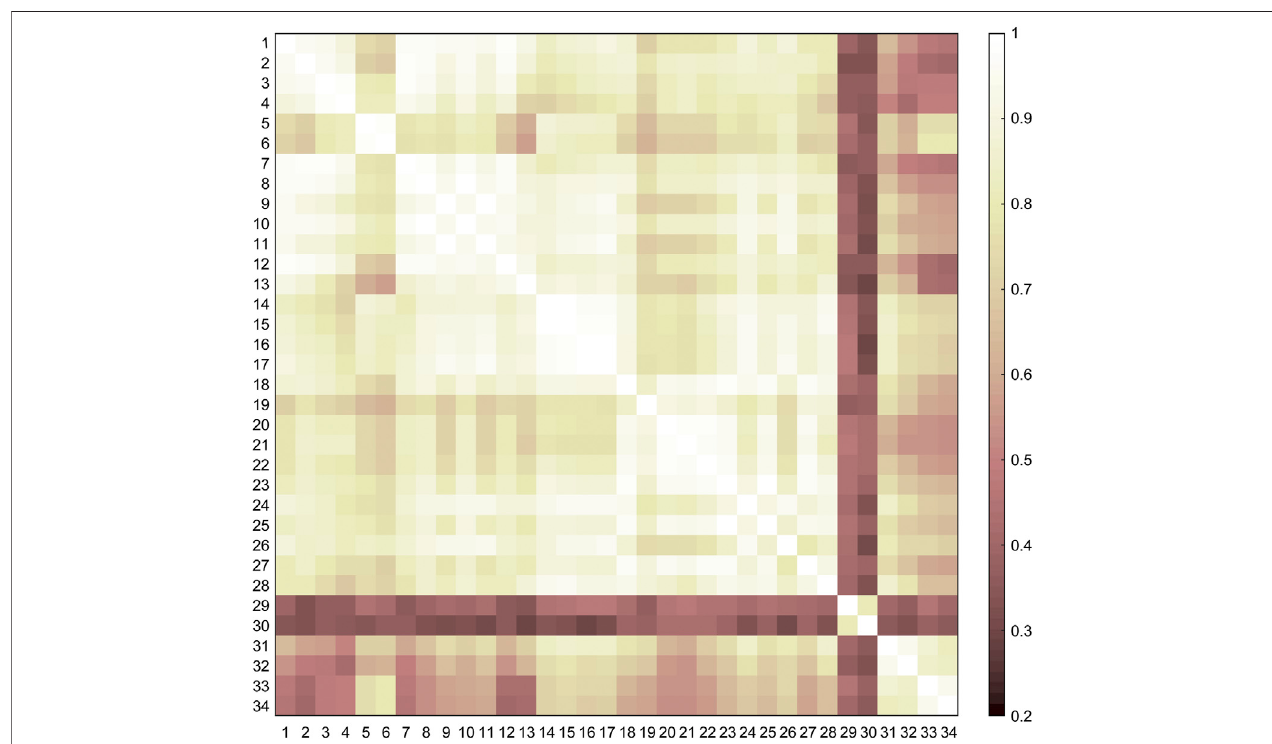
FIGURE 2 | Similarities among the motor tasks. The similarities are the averages across the subjects ( n (cid:1) 9) and are used as the input of cluster analysis.